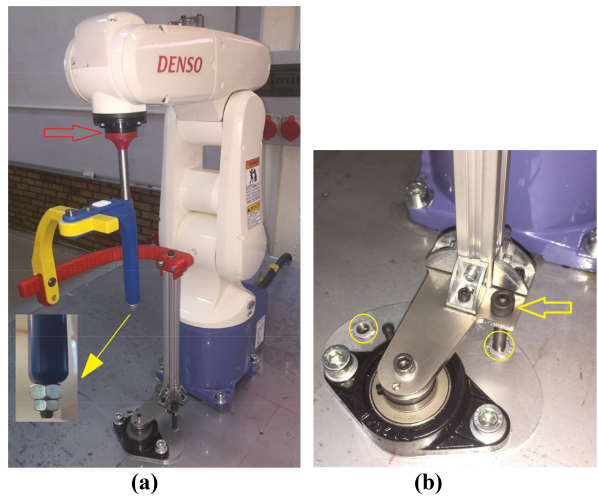
Figure 9. FE and PS configuration and rotatable system.